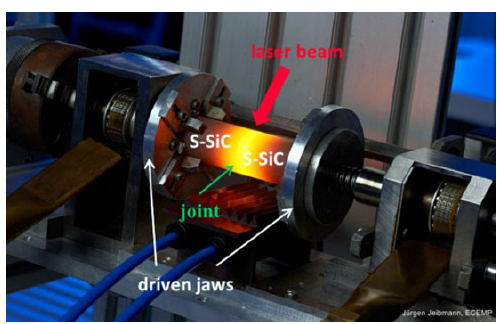
Fig. 9 Laser joining of sintered SiC capsule specimens. Reproduced with permission from Ref. [97], © Taylor & Francis